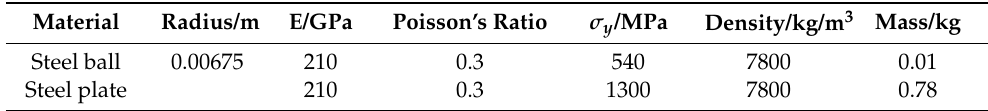
Figure 8. Experiment facilities: ( a ) experimental steel ball, ( b ) experimental steel plate, ( c ) leveling instrument. Table 3. Material parameters of the ball plate.